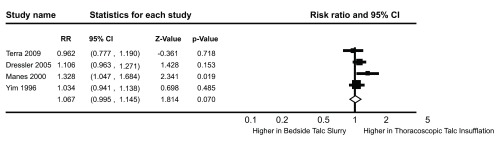
Pooled relative risks (RRs) of success rates post talc pleurodesis.
RR,
risk ratio,
CI, confidence interval.